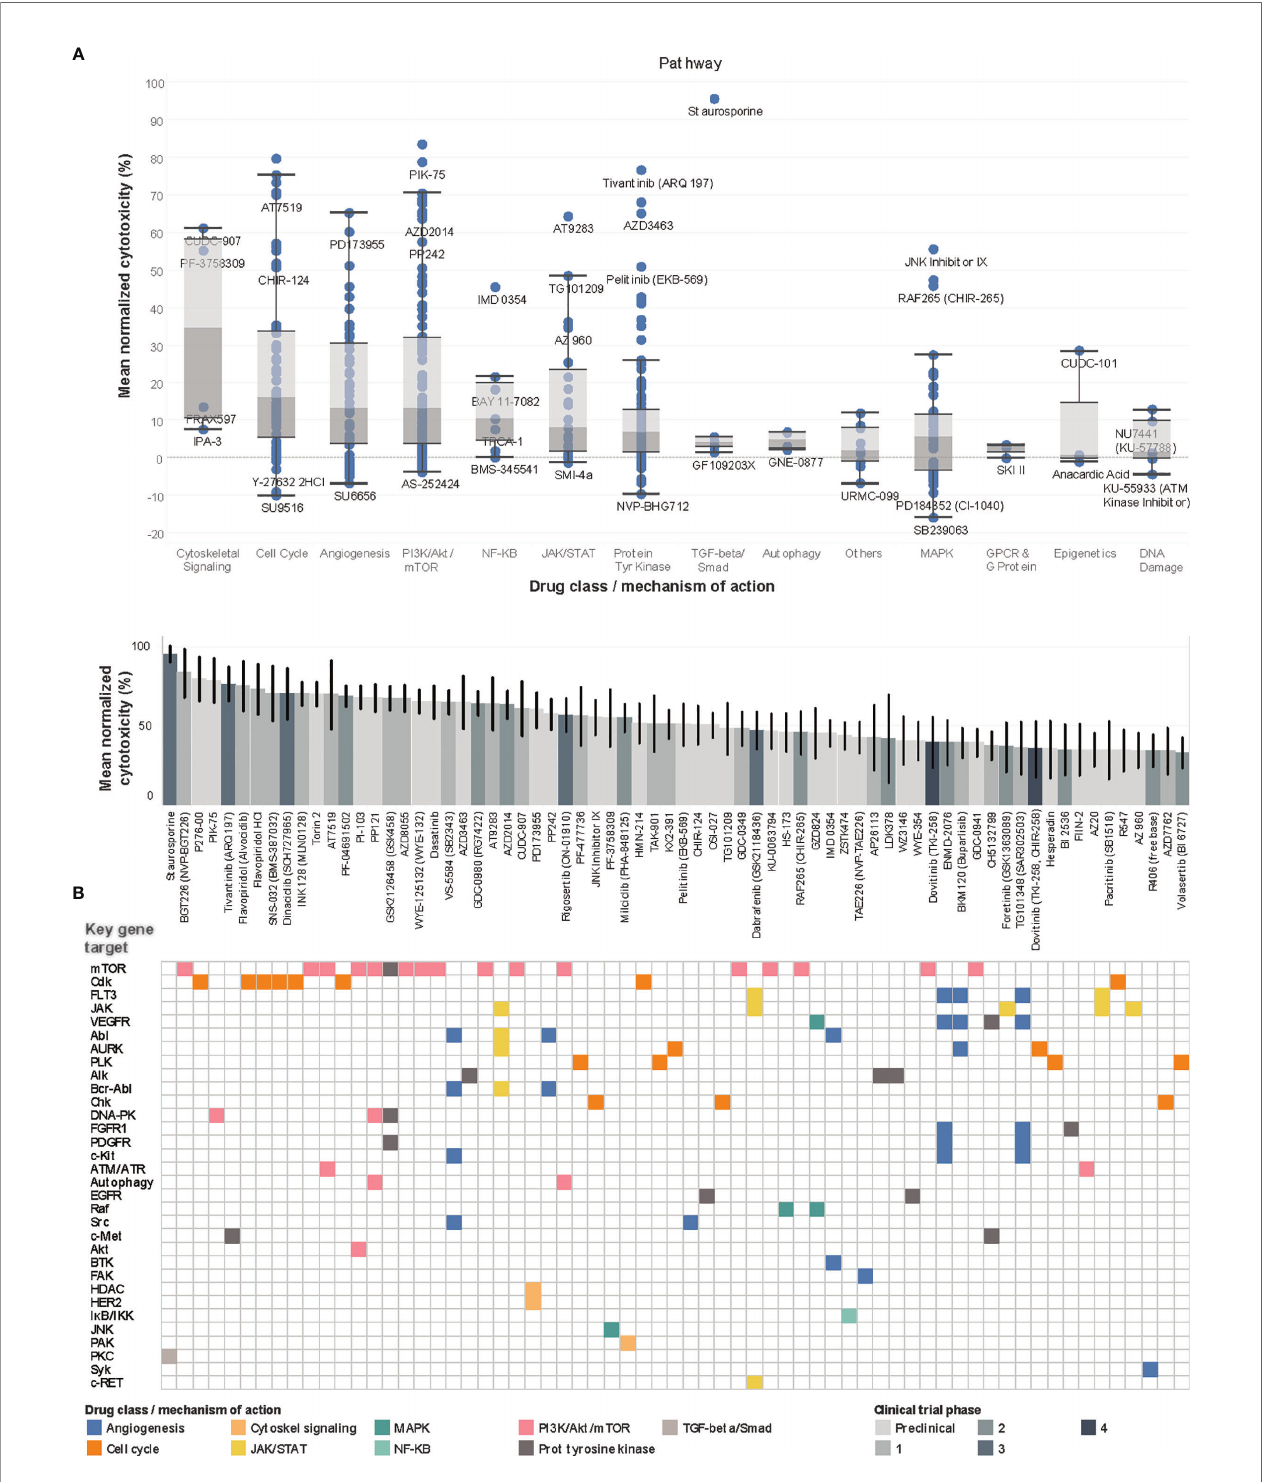
FIGURE 3 | Drug screen of neuroblastoma PDCs identify agents targeting PI3K pathway and cell cycle. (A) Boxplots of drug classes of all 418 compounds, ranked by mean normalized cytotoxicity, with drug names of outliers labelled. (B) Waterfall plot of top 70 drug hits with >33% cytotoxicity in top panel, with current clinical trial phase indicated in shades of grey; bottom panel re fl ects corresponding key gene targets and main mechanism of action. Among the 70 top drug hits, 18 (26%) had progressed beyond Phase 1 trials. The 5 top drug hits included BGT226, a class I PI3K/mTOR inhibitor for PI3K a / b / g ; P276-00, a Cdk inhibitor; PIK-75, a PI3K inhibitor; and tivantinib, a c-Met receptor tyrosine kinase non-ATP-competitive inhibitor (83.6%, 79.7%, 78.9%, 76.7% mean normalized cytotoxicity,